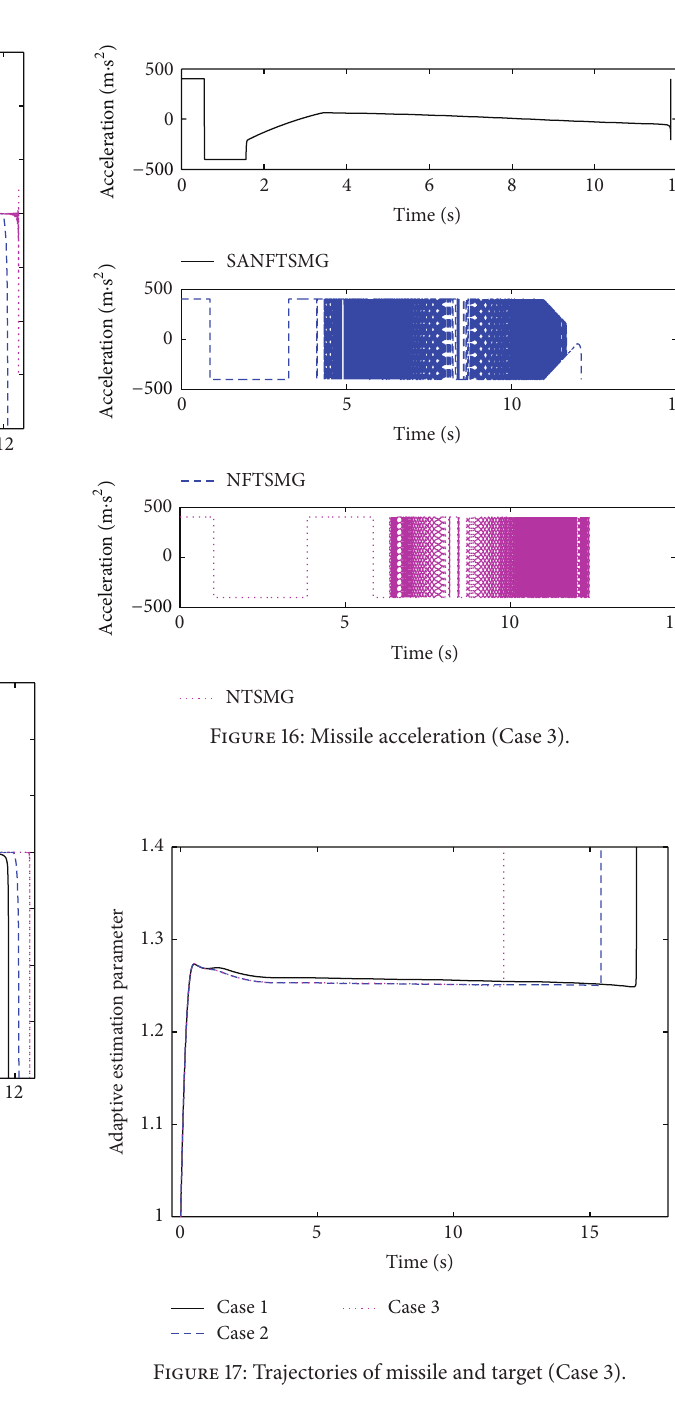
Figure 17: Trajectories of missile and target (Case